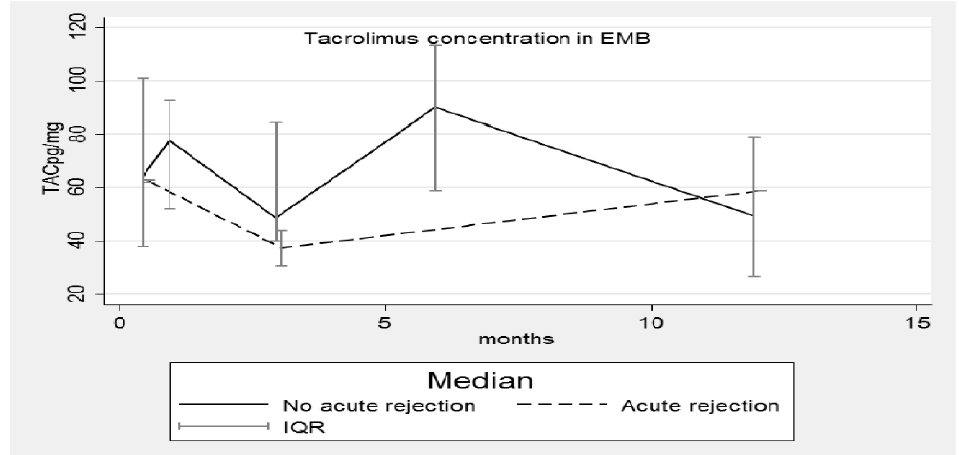
Figure 5. Median concentration–time profile of TAC in EMBs with and without acute rejection episodes. TAC: Tacrolimus; EMB: Endomyocardial biopsy; IQR: interquartile